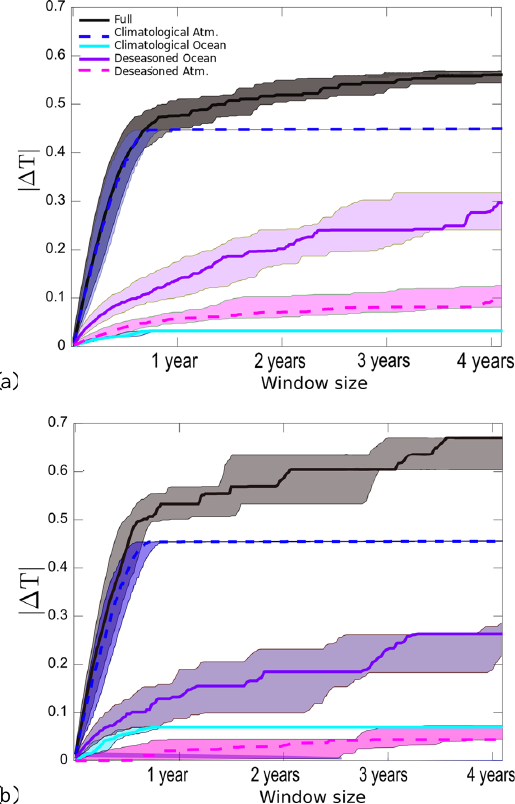
Fig. 8. The absolute magnitude of OHC change ( | 1 T | in ◦ C) at- tributed to each component. Coloured regions illustrate the respec- tive first quartile (upper line), median (thick line) and third quar- tile (lower line) of the largest | 1 T | within a sliding window of an increasing size. The AV box model is indicated by (a) , while (b) shows the FV box model using the RAPID-based data. Note the OHC variability attributable to the seasonally varying clima- tology (referred to as “climatological”) stabilizes within a year, while the importance of the deseasoned components increase with time/window size. Further, the figure highlights the partitioning be- tween the components, illustrating the magnitude of the deseasoned component, and the timescales over which this has an impact.